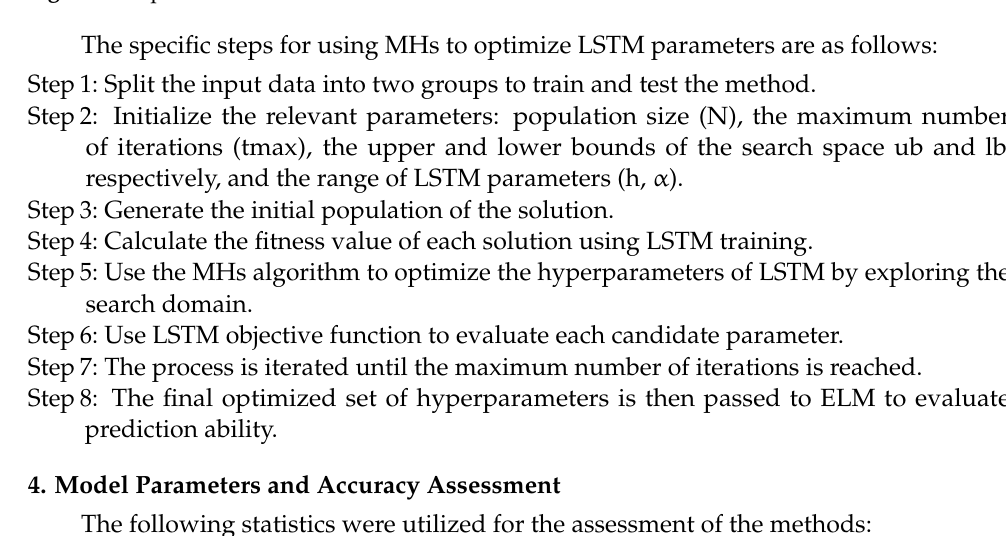
Figure 6. Improved LSTM model.